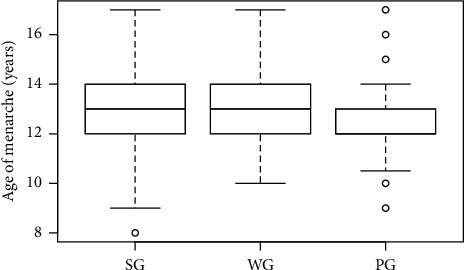
Age of the first menstruation and dysmenorrhea in respondents. A statistically significant difference was revealed between the PG and SG groups (p=0.011), as well as between the PG and WG (p=0.002), and between the WG and SG (p=0.045). PG, women with dysmenorrhea during every cycle, SG, women with dysmenorrhea occasionally, and WG, women without dysmenorrhea.